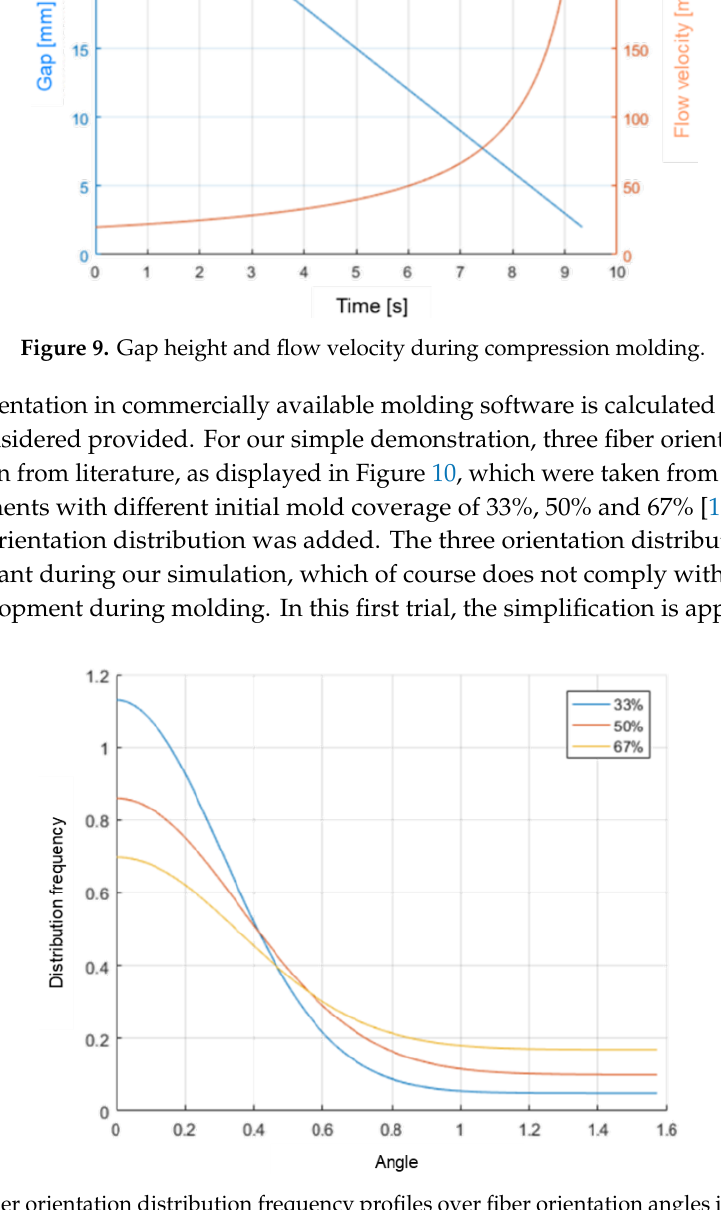
Figure 10. Fiber orientation distribution frequency profiles over fiber orientation angles in compression molded plates with 33%, 50% and 67% initial mold coverage .